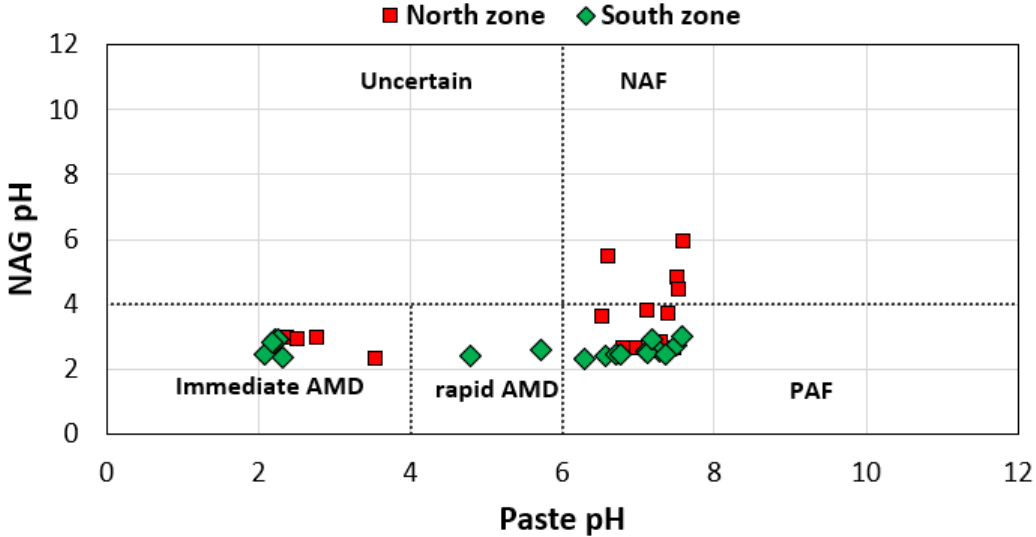
Figure 11. Paste pH vs NAG pH values for selected samples from the southern and northern zones (NAF = Non-acid forming, PAF = Potentially acid forming).